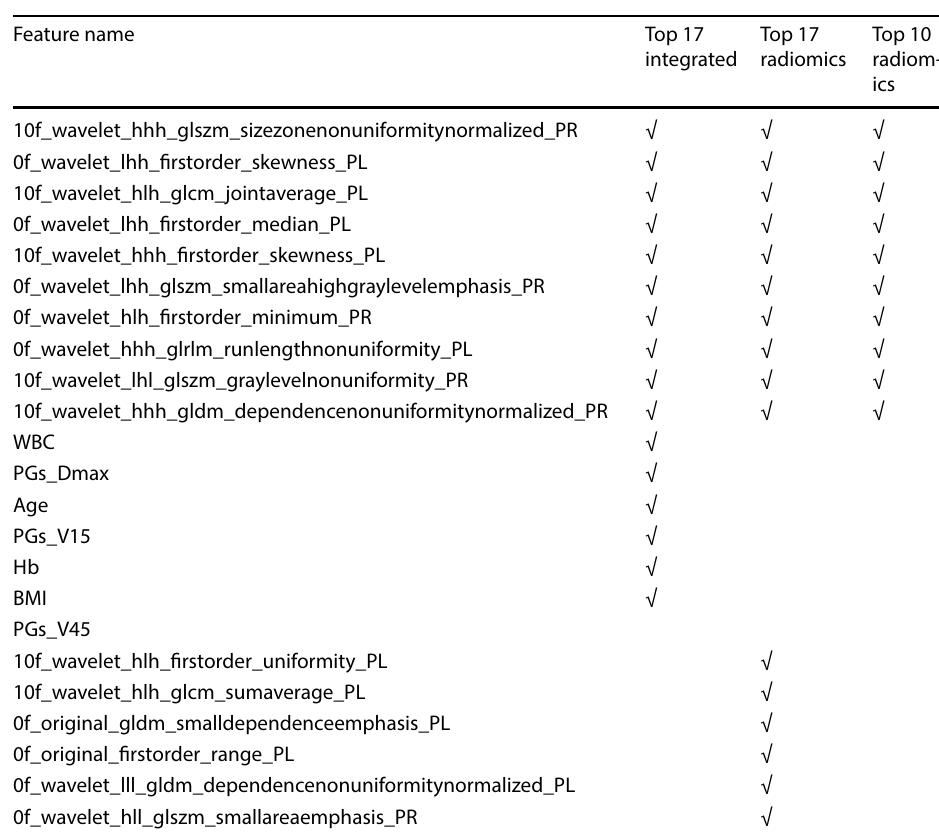
‘PL’ and ‘PR’ respectively mean the left parotid gland and right parotid